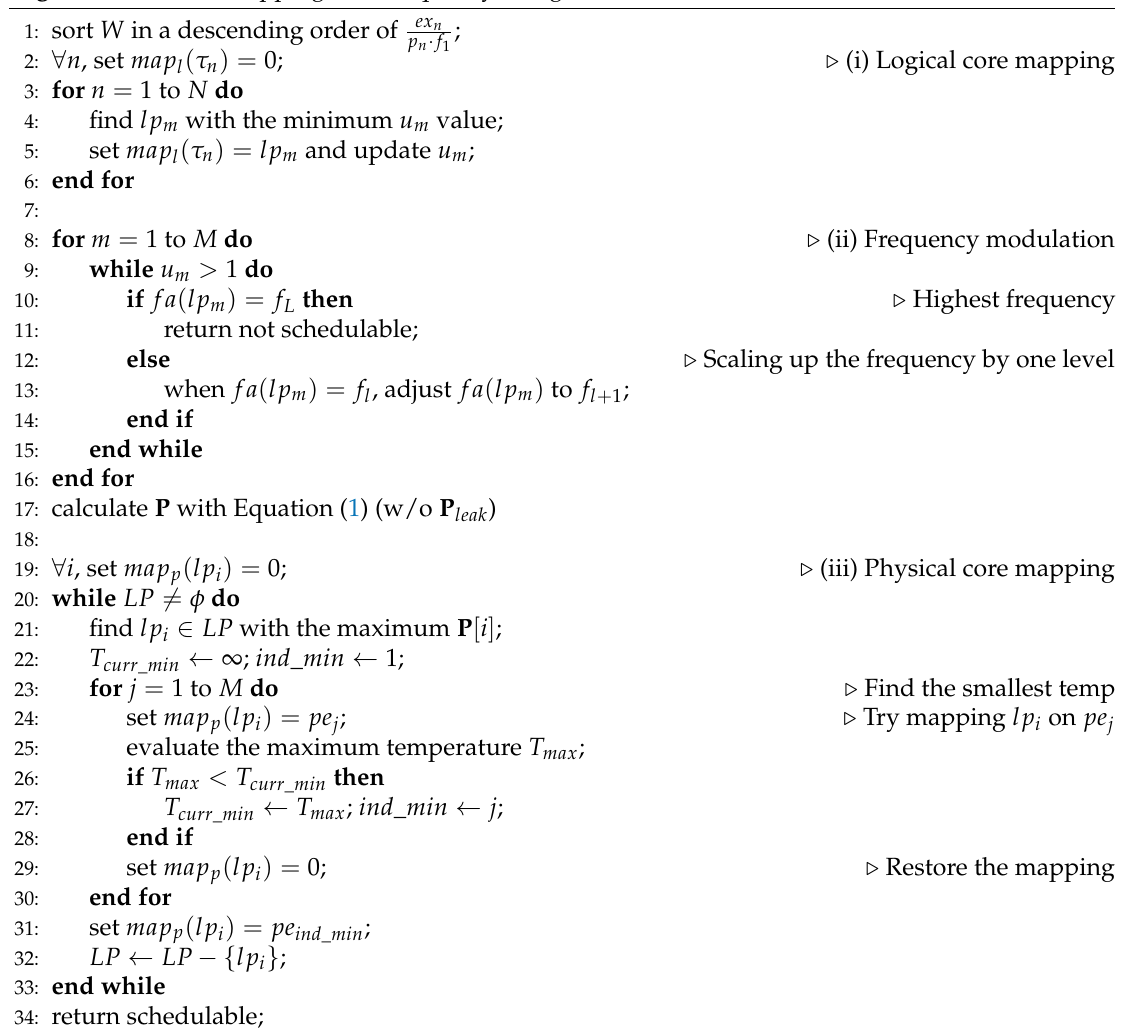
Algorithm 1 Initial Mapping and Frequency